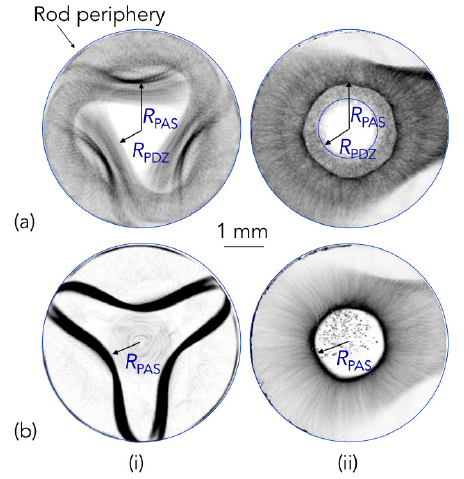
Figure 4. Top views of path lines of particles of 15µm in diameter ( a ) before and ( b ) after PAS formation in ( i ) the rotating frame of reference and in ( ii ) teh laboratory frame by averaging over 7s (10 times fundamental periods of hydrothermal wave (HTW)) in a liquid bridge of Pr = 28.6, Γ = 0.64 ( R = 2.5mm), and V / V = 1.0: ( a ) Ma = 3.13 × 10 4 and ( b ) Ma = 4.30 × 10 4 . Note that 0 white regions at the top and bottom right in the images in the column ( ii ) are the regions where the light from the light source never irradiates in the liquid bridge: the light is supplied to the liquid bridge through the free surface from the left in these images, and one cannot avoid the refraction of the light due to the curvature of the free surface. Those regions become vague and are not apparent by integrating images for a long period in the rotating frame of reference as shown in the column ( i ). Ma is evaluated by applying H for the characteristic length L . (Figure 6 in Gotoda et al.